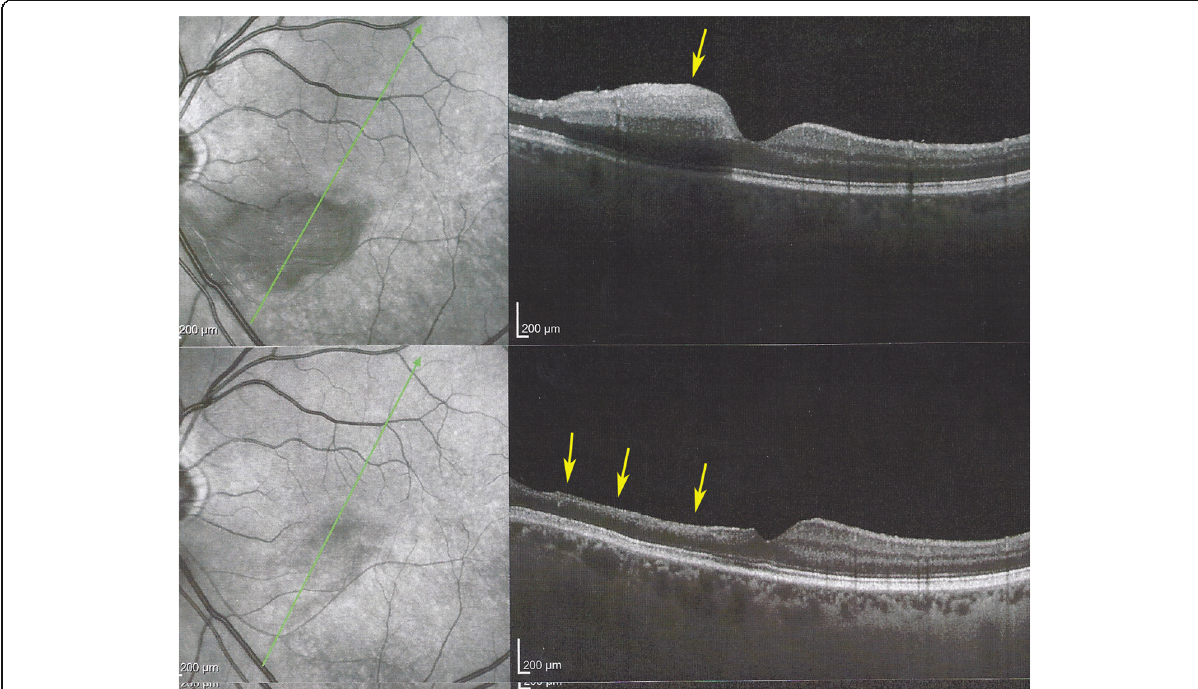
Fig. 12 Evolution of OCT views of infarcted zone in the acute phase (top) showing retinal oedema (arrow) and 6 months later (bottom) showing atrophy of inner retina (arrow) while external retina is conserved. (case